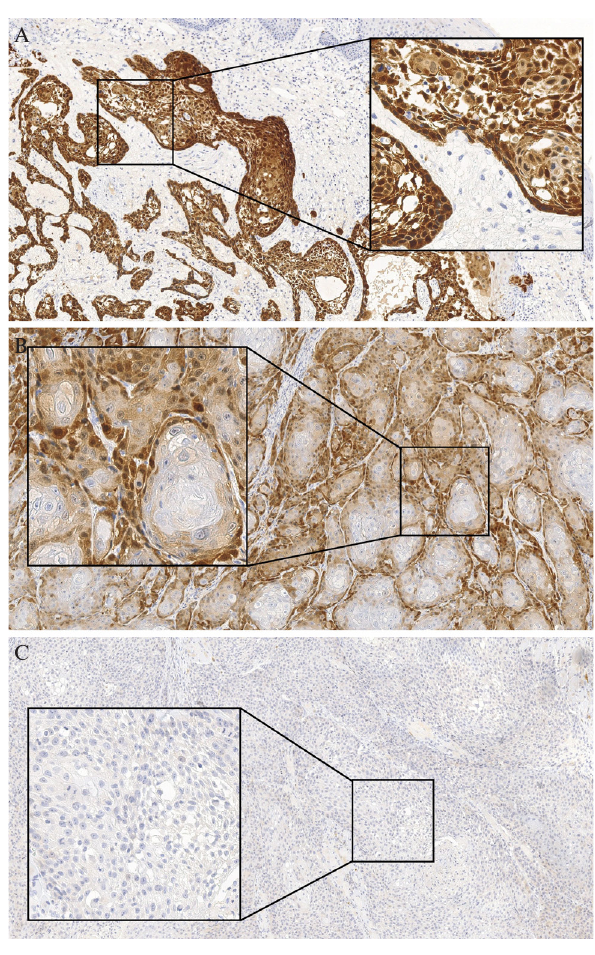
Fig. 1. Immunohistochemical staining of